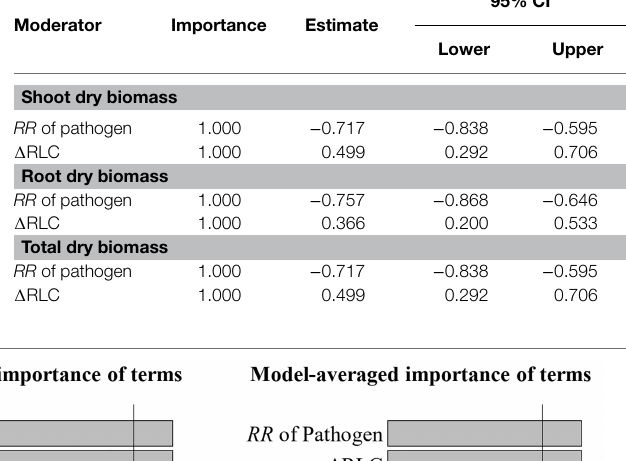
TABLE 1 | The details of significant importance of moderators for the effect size difference of arbuscular mycorrhizal fungi (AMF) on the plant biomass under plant pathogenic microbes and no-pathogenic